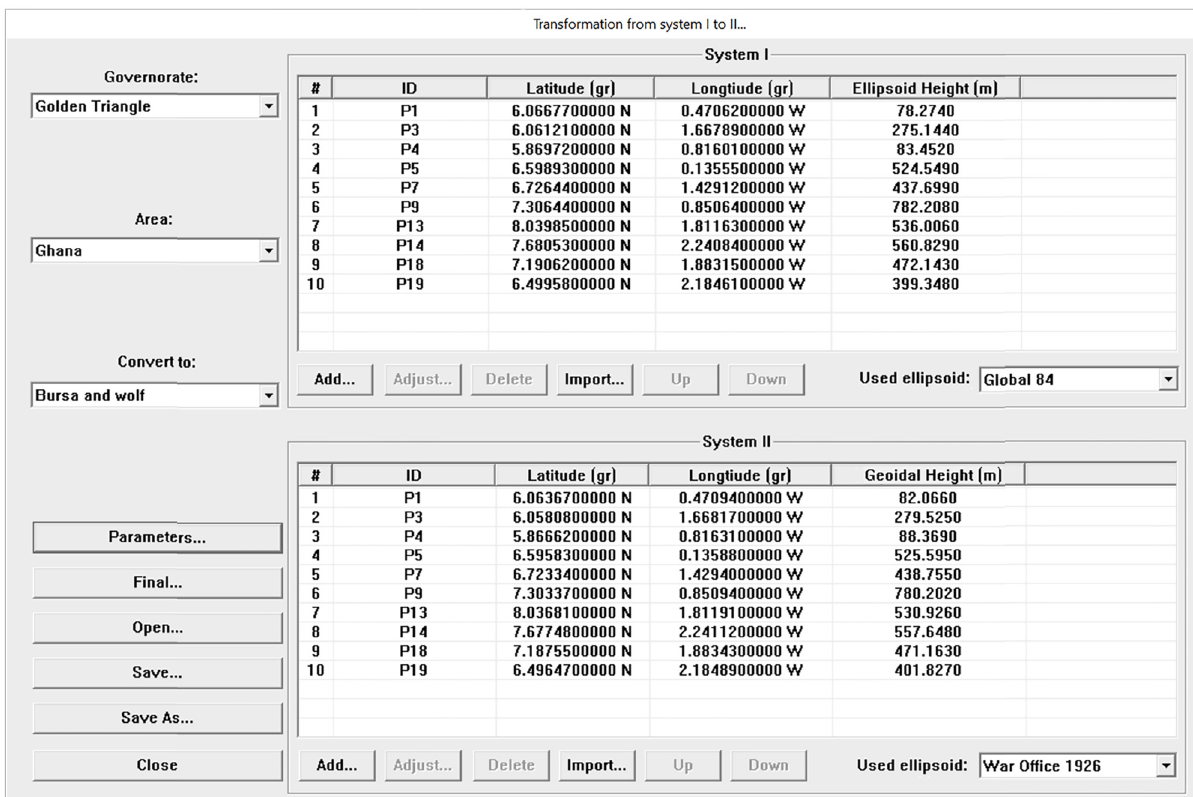
Figure 8: Dialog for calculating transformation